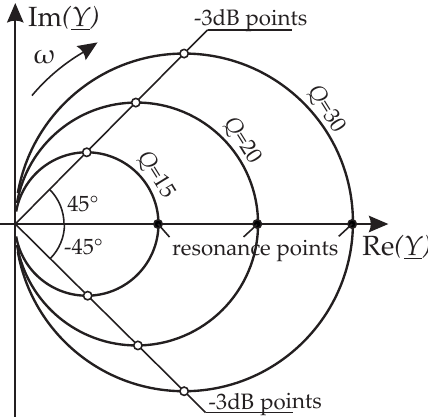
Figure 2. Nyquist plots of the mechanical admittance of three